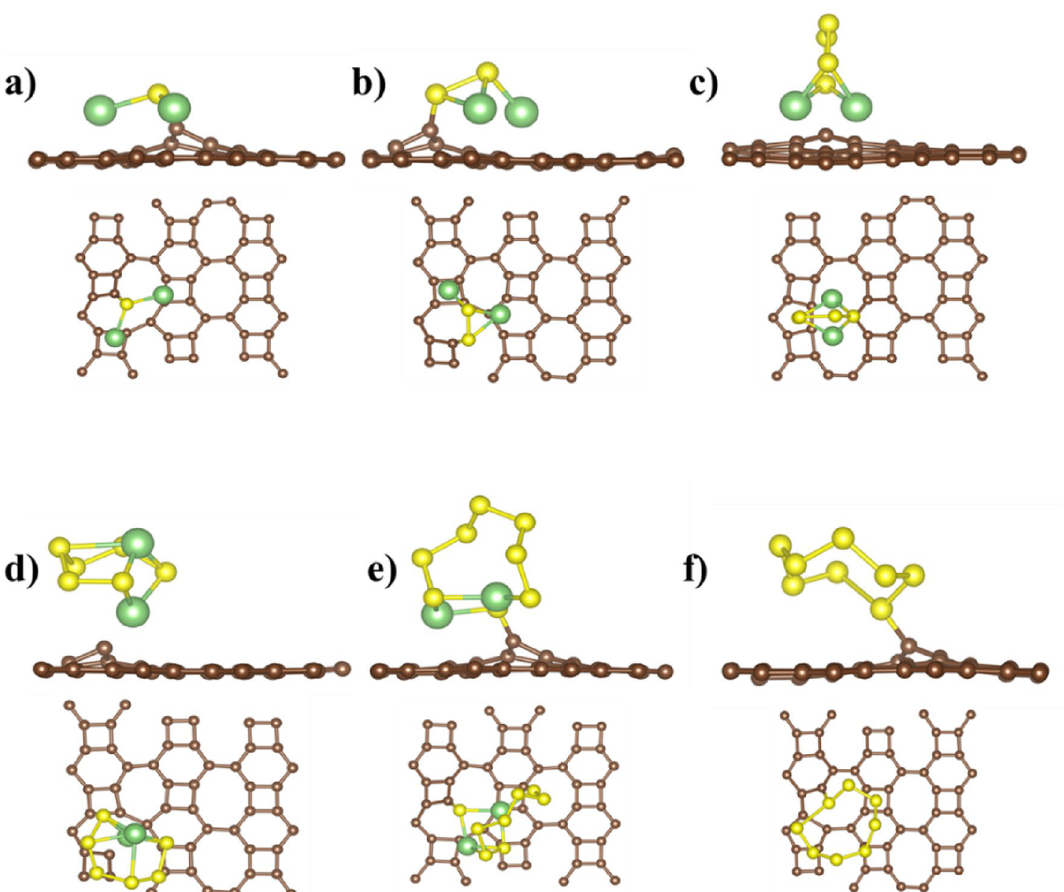
Figure 3. Ground state configuration of defective BPN sheet, (D1) adsorbed with ( a ) Li 2 S ( b ) Li 2 S 2 ( c ) Li 2 S 4 ( d ) Li 2 S 6 ( e ) Li 2 S 8 and ( f ) S 8 clusters. The brown, green, and yellow spheres correspond to C, Li, and S atoms,